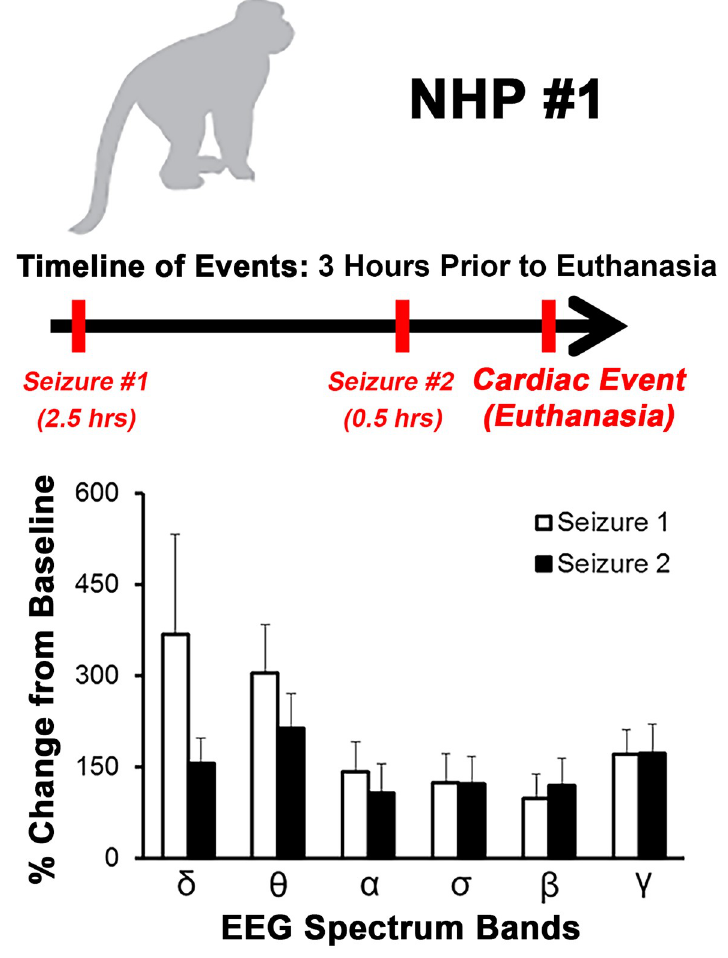
Fig 13. Timeline of events for NHP #1 3 hrs prior to euthanasia and profile of seizure events. Percent change in EEG waves with +/- standard deviations (error bars) are